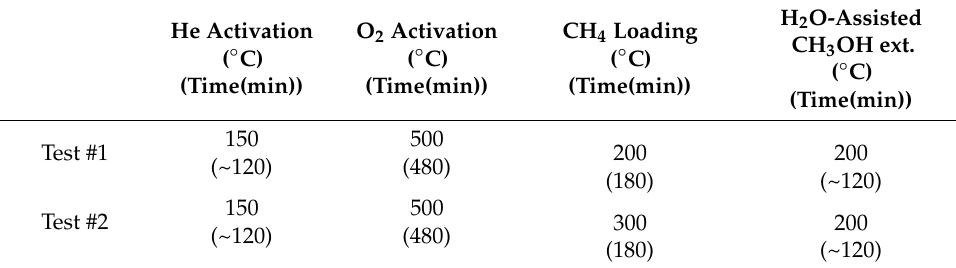
Table 1. Test conditions applied for the DMTM